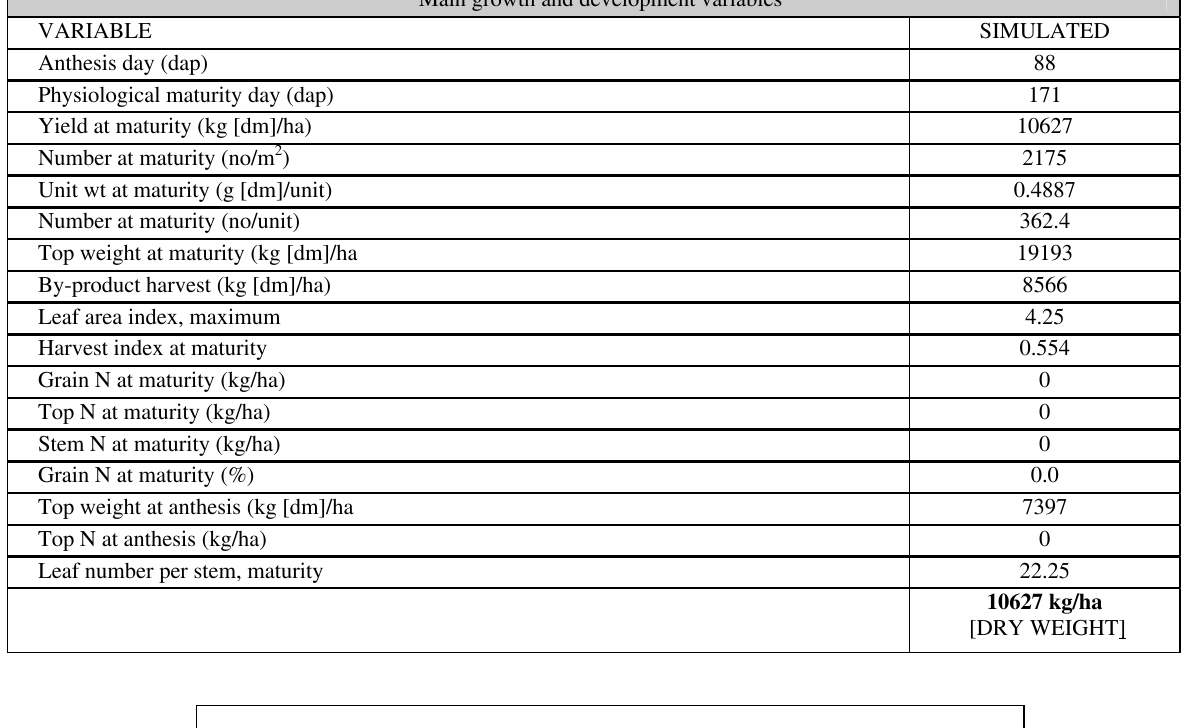
Table 3 . Example of model output